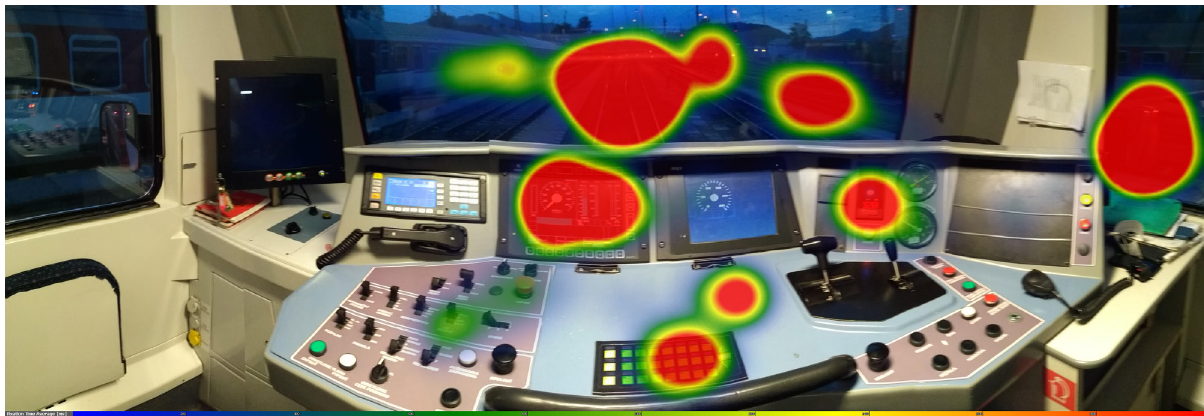
Figure 7: Heatmap of the train driver attention during driving through station Dolný Hričov